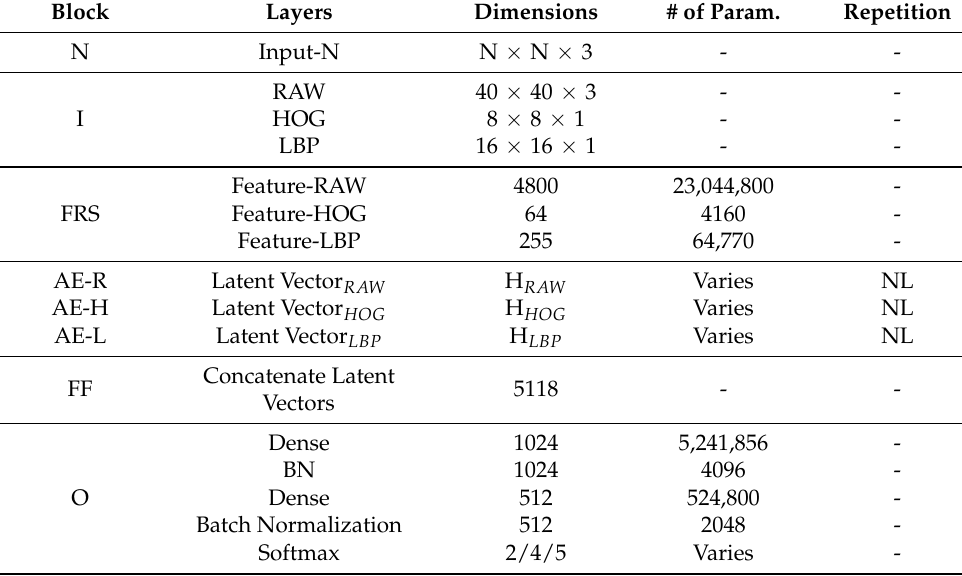
Table 1. Proposed model architecture. H RAW , H HOG , H LBP ∈ (Feature-X, Feature-X/K, K*Feature-X) with activation map. Abbreviations: Feature-RAW, Feature-HOG, Feature-LBP (Feature-X ∈ ), number of neurons (K), Number of hidden Layers (NL).